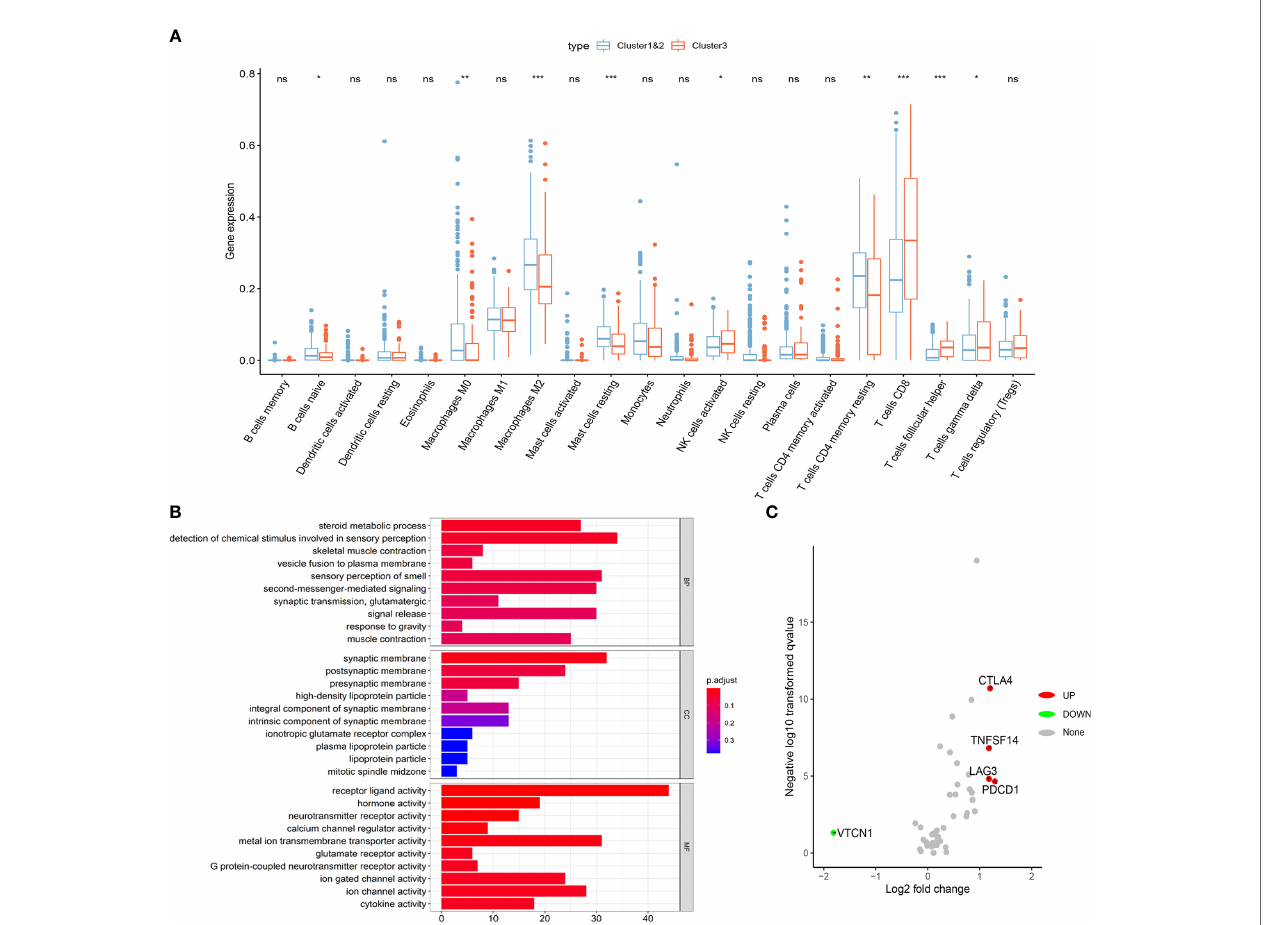
FIGURE 5 | Distinct immune microenvironment of ccRCC between m6A score Low and m6A score High groups in silico . (A) To further explore role of m 6 AMS involved in tumor immune microenvironment characterizations, a CIBERSORT algorithm was applied to evaluate the immune cells in fi ltration. (B) Functional enrichment analyses were performed to indicate to annotate biological process, molecular function and cellular components of cluster 1&2 and cluster 3. (C) Volcano plots were constructed using fold-change values and adjusted P. The red point represents the up-regulated and the blue point indicates the down-regulated immune checkpoint molecules with statistical signi fi cance between cluster 3 and cluster 1&2 (ns, not signi fi cant; *p< 0.05, **p< 0.01, ***p<